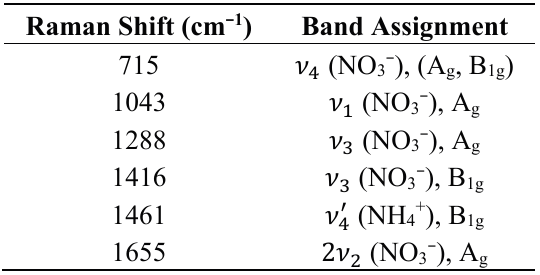
Table 1. Raman band assignments for ammonium